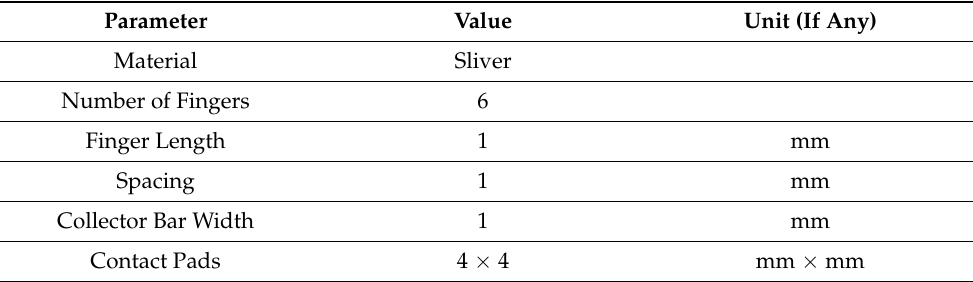
Table 1. Design parameters of rectangular and circular